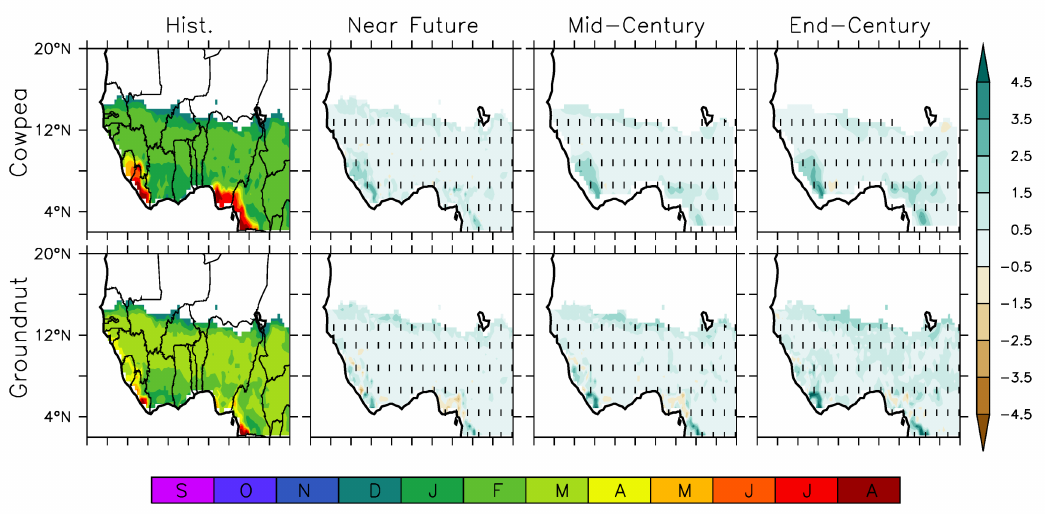
Figure 8. Same as Figure 7 but for the legumes, cowpea and